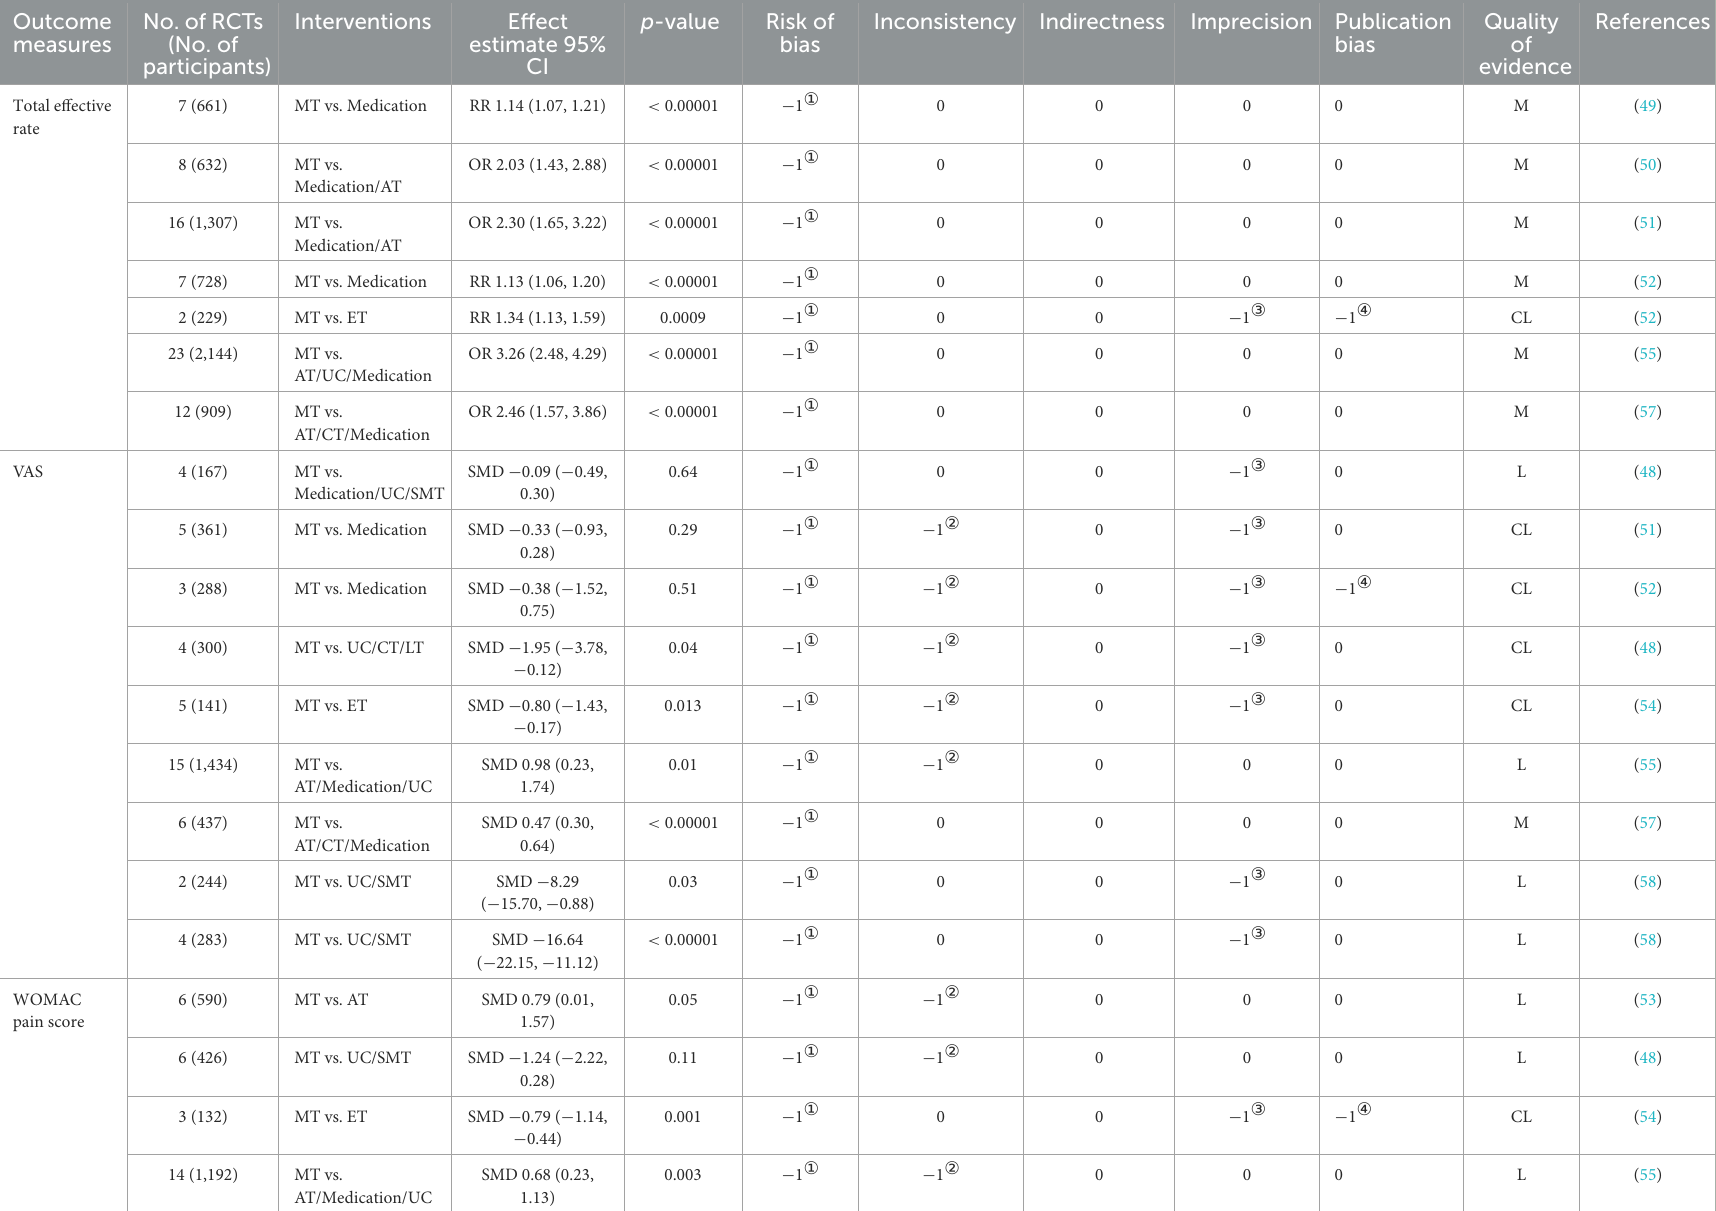
TABLE 5 Results of the